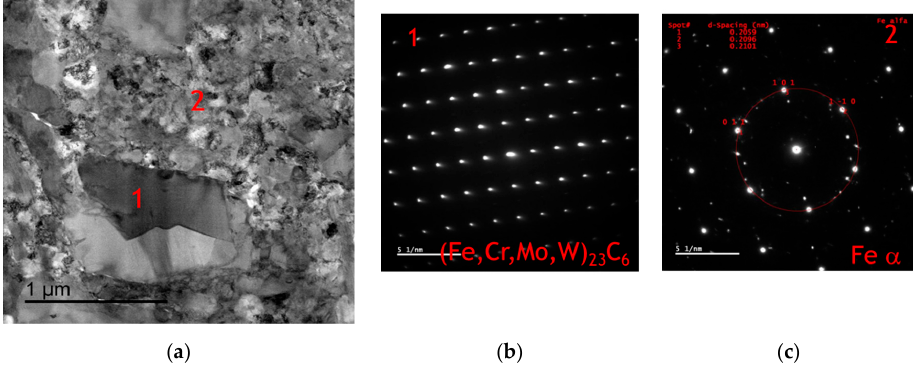
Figure 6. TEM image ( a ) and SAD patterns ( b , c ) in the crystallized region: 1. carbides; 2. Fe α .